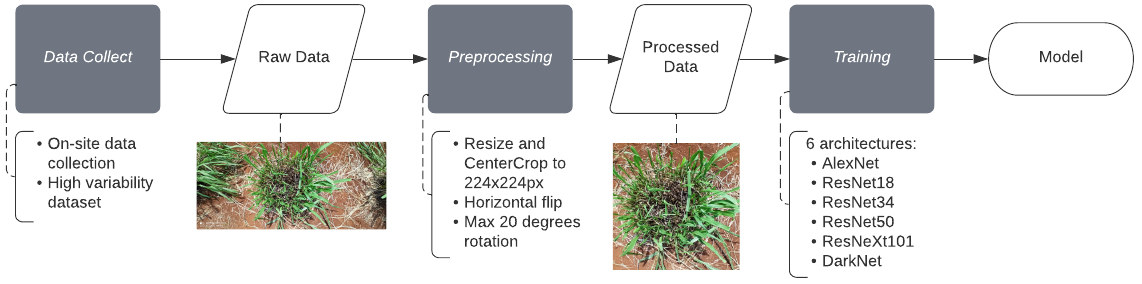
Figure 1. Workflow diagram of the adopted